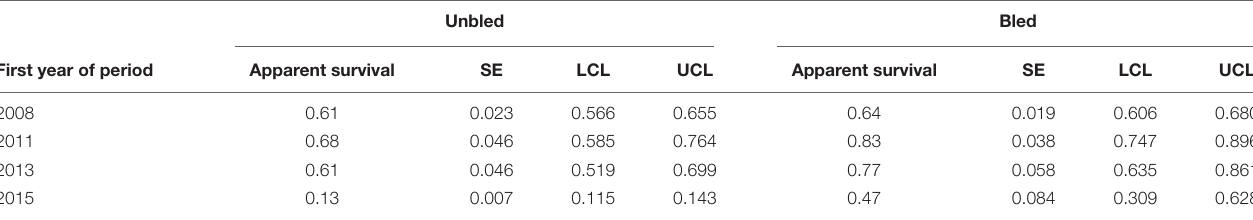
TABLE 6 | Estimates of apparent survival, standard error (SE), and 95% confidence limits (LCL, UCL) for the top model for tagged horseshoe crabs released in coastal Delaware to Virginia from 2008 to